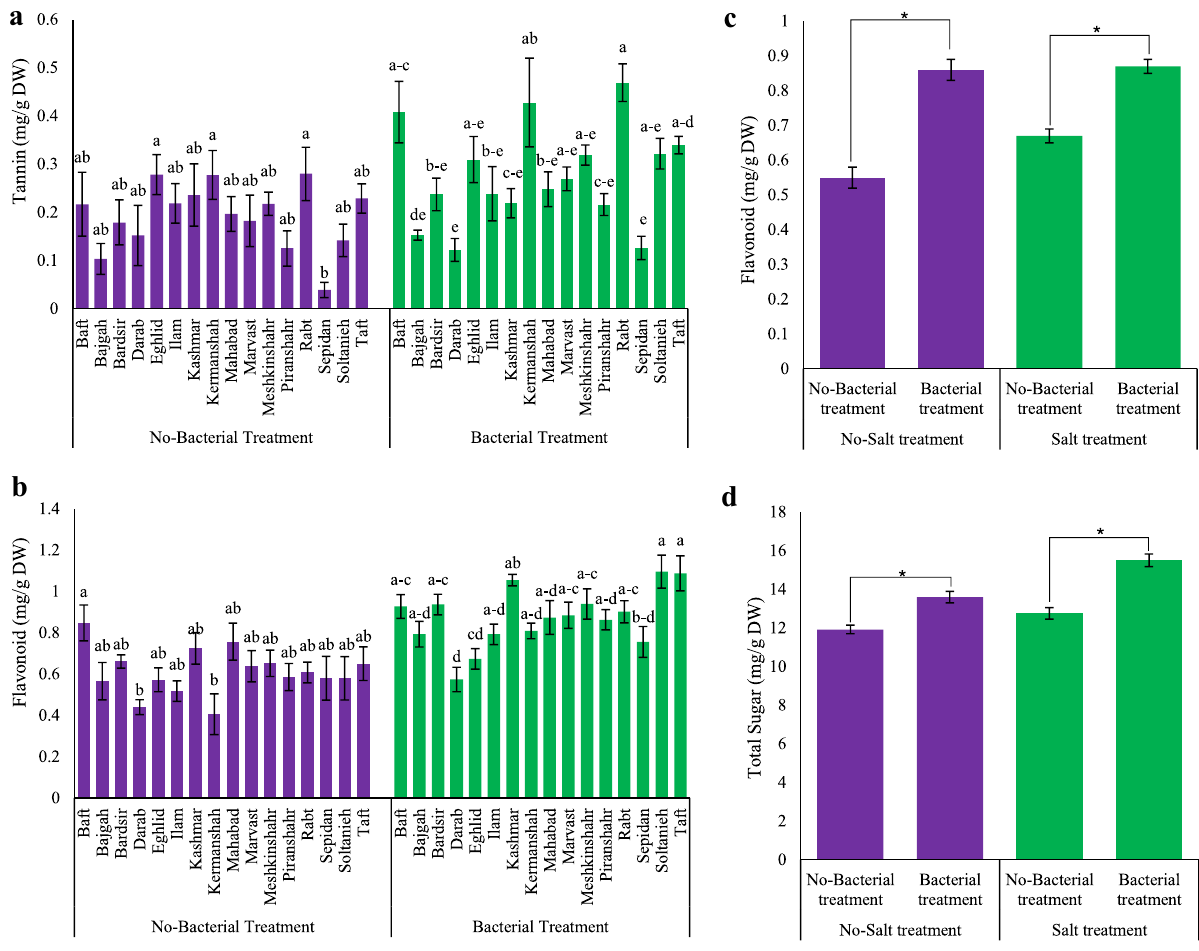
Figure 5. Measured parameters variation under studied treatments. ( a) Tannin, ( b) and ( c) Flavonoid, and ( d) Total sugar. According to the analysis of variance, only the multiple effects of Azotobacter and salinity showed a significant difference, just its mean comparison is shown. Mean values with the same letters are not significantly different ( p ≤ 0.05), Tukey test. Bars stand for standard error